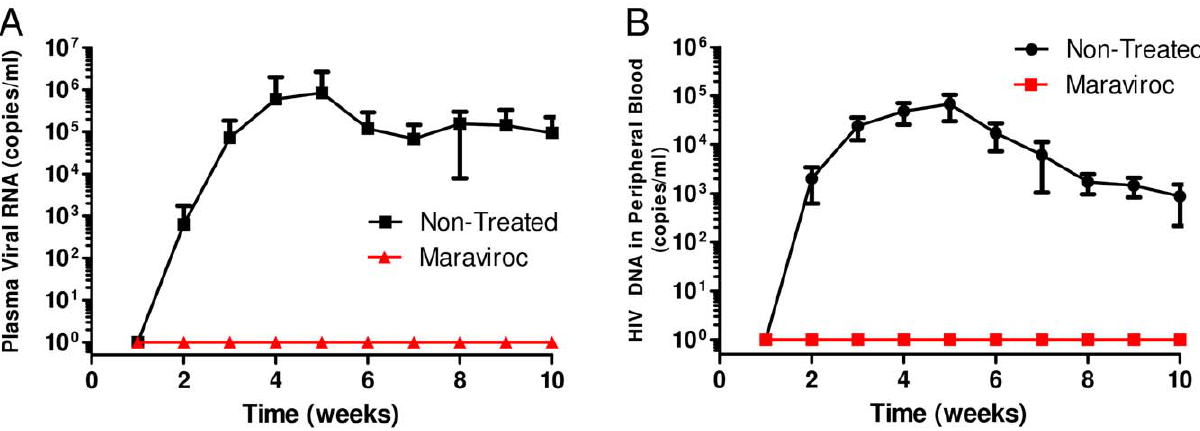
Figure 3. RNA and DNA viral loads in mice administered with maraviroc. RAG-hu mice were challenged by vaginal route after oral administration of raltegravir as described in Methods. Blood was collected weekly. Viral RNA was extracted from the plasma fraction and DNA was extracted from the cellular fraction. Viral RNA and DNA loads were determined by Q-RT-PCR as described in methods. A. RNA viral loads B. DNA viral loads.